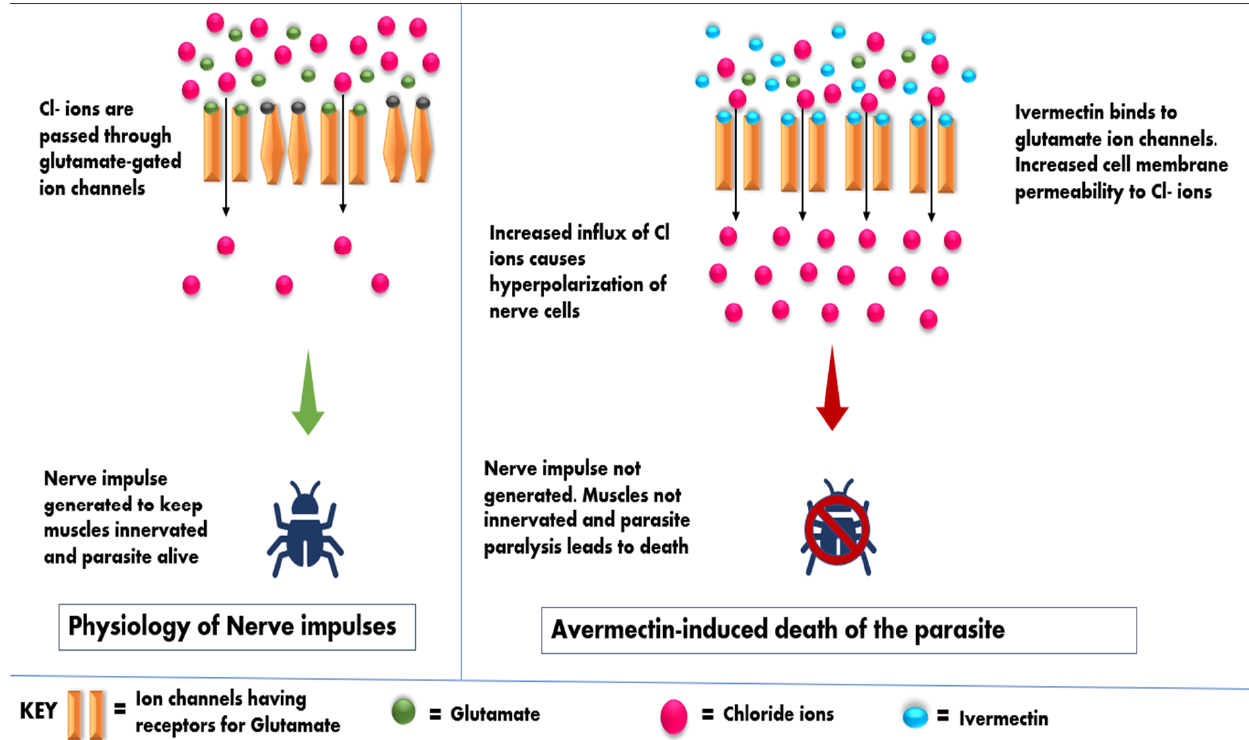
Figure 3. Mode of action of avermectins.